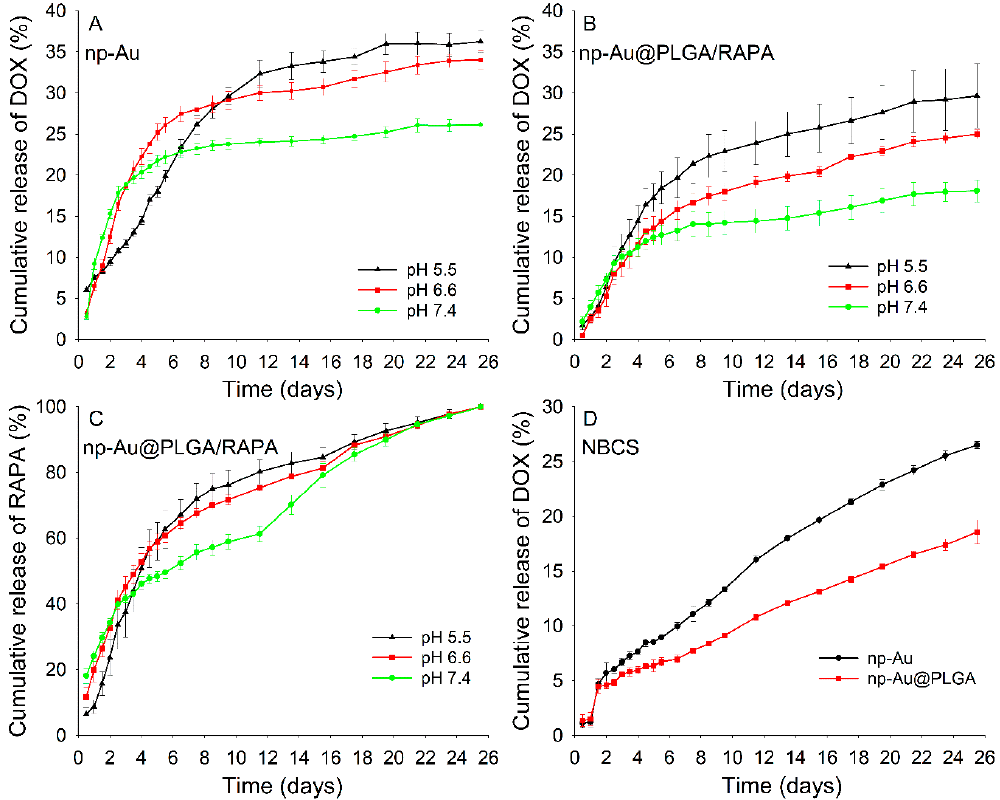
Figure 11. Cumulative release of drugs as a function of time. ( A ) DOX from np-Au in buffers at different pH, ( B ) and ( C ) DOX and RAPA, respectively, from np-Au@PLGA/RAPA in buffers at different pH, and ( D ) DOX from np-Au and np-Au@PLGA/RAPA in newborn calf serum (NBCS) at pH 7.4.